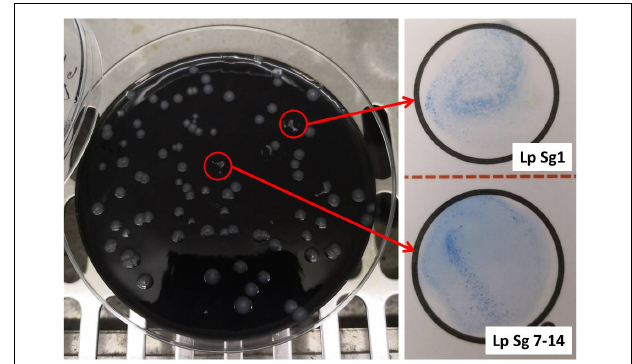
FIGURE 1 | Left, Buffered Charcoal Yeast Extract (BCYE) agar after 14 days of incubation at 37 ◦ C in modified atmosphere (2.5% CO 2 ). Legionella colonies appeared white-gray, shiny, round in shape with whole edges; Right, identification of Legionella pneumophila using latex agglutination test with mono (Lp Sg1) and polyvalent antisera (Lp Sg